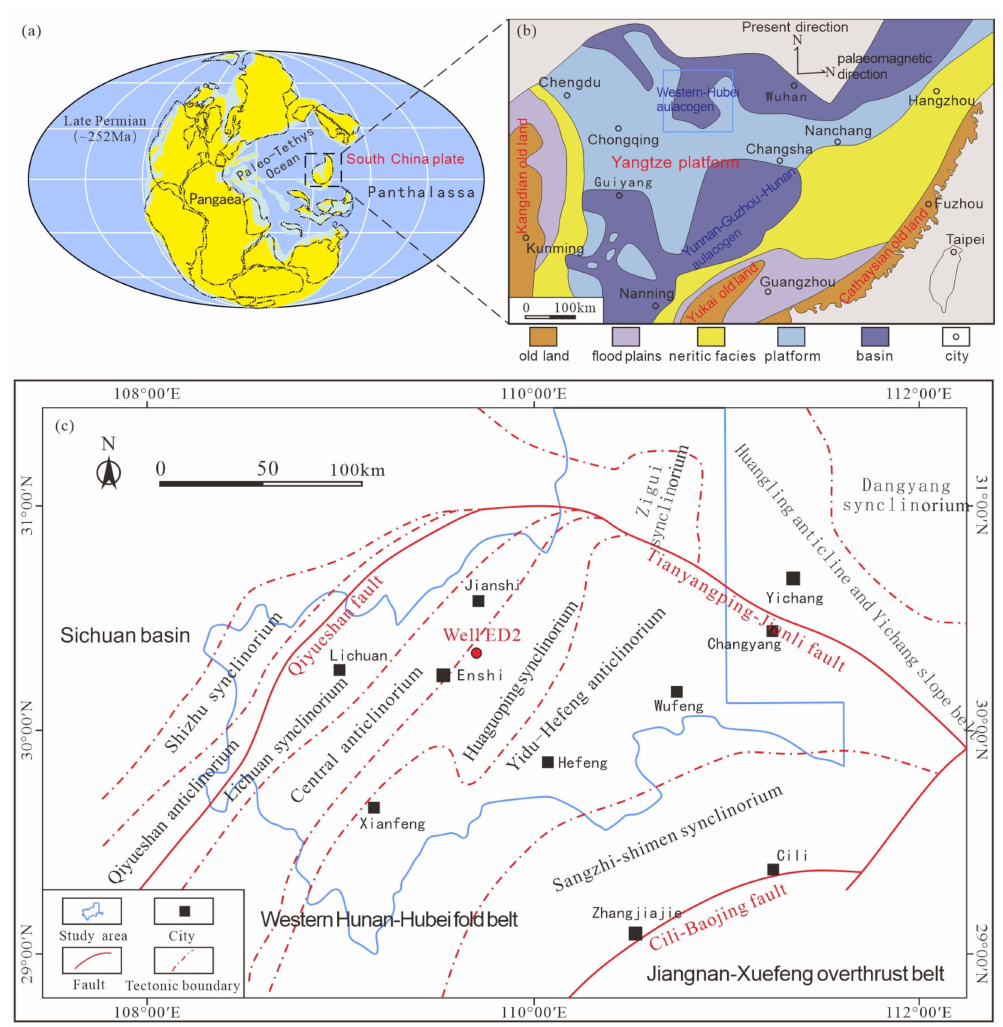
Figure 1. ( a ) Global paleogeographic map at the end of the late Permian (modified from [37]), ( b ) Paleogeography of late Permian lithofacies of the South China plate (modified from [30]), ( c ) Present-day tectonic map of Western